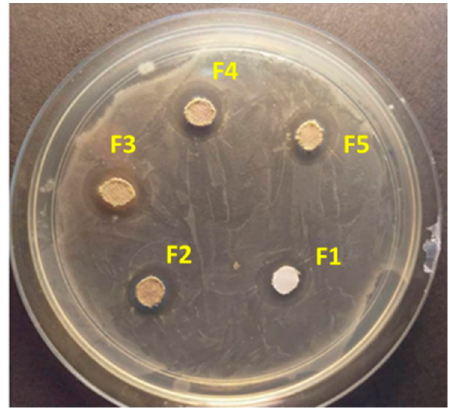
Figure 6. Antibacterial activity of Ag 2 O-loaded PETs. Table 3. Antibacterial activity of the samples.